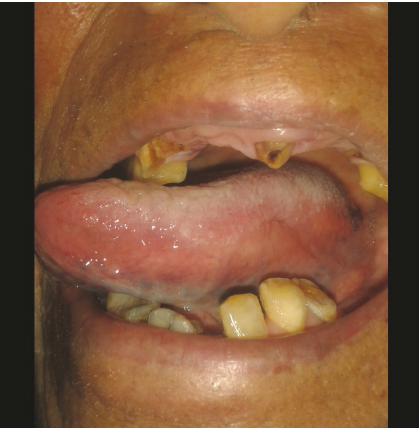
Figure 3: Complete disappearance of ulcerated lesion at the end of 2-month course of antituberculous therapy